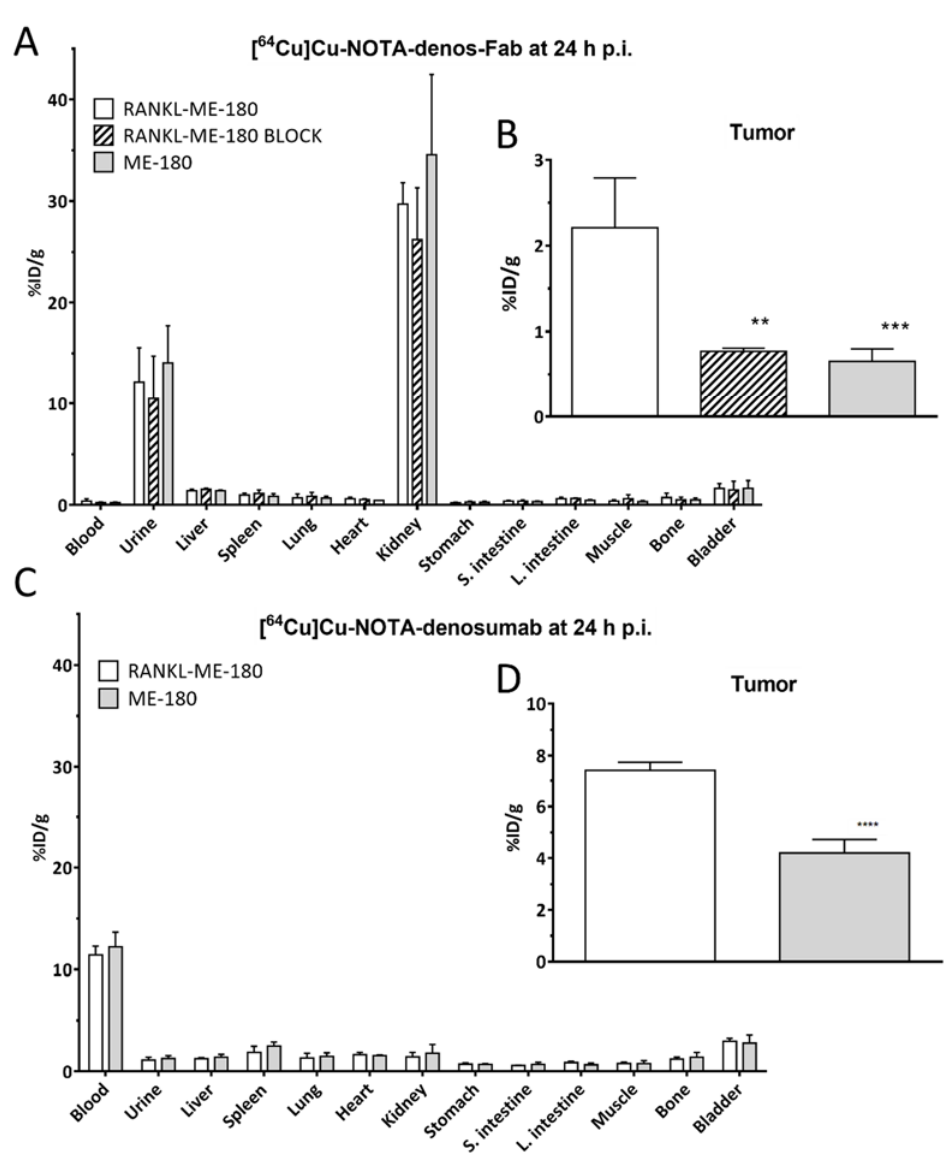
Figure 6. Ex vivo biodistribution analysis of [ 64 Cu]Cu ‐ NOTA ‐ denos ‐ Fab/denosumab. Ex vivo biodis ‐ tribution analysis of [ 64 Cu]Cu ‐ NOTA ‐ denos ‐ Fab ( A ) in organs and ( B ) in the tumor and [ 64 Cu]Cu ‐ NOTA ‐ denosumab ( C ) in organs and ( D ) in the tumor 24 h post radiotracer injection (mean ± 1 stand ‐ ard deviation; % ID/g: percentage injected dose/gram; p.i.: post injection; ** p ≤ 0.01; *** p ≤ 0.001; **** p ≤ 0.0001).